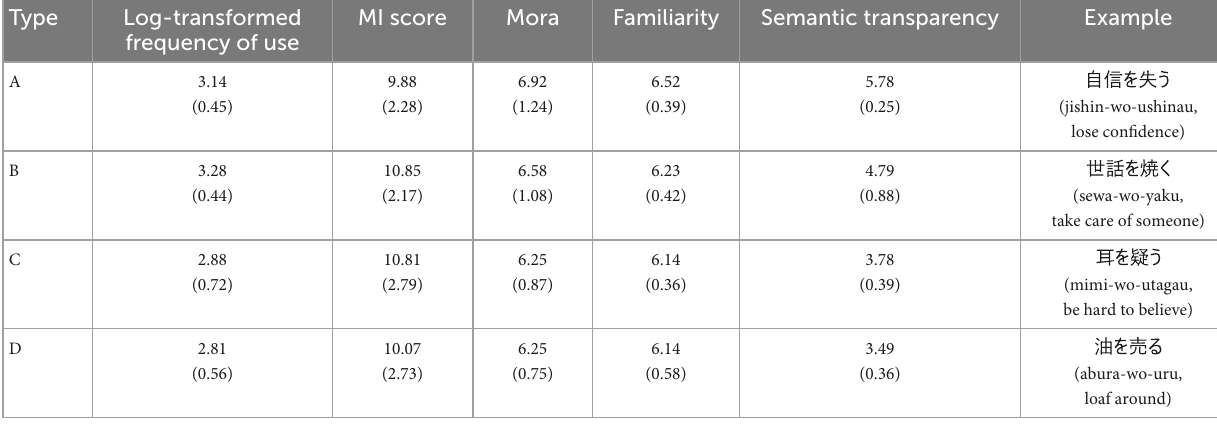
TABLE 2 Summary of characteristics of the test